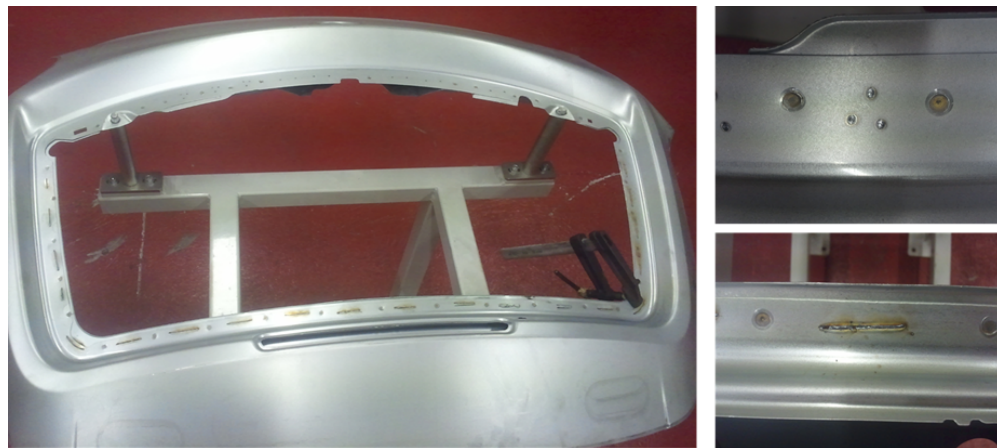
Figure 11. Target product of the case study.